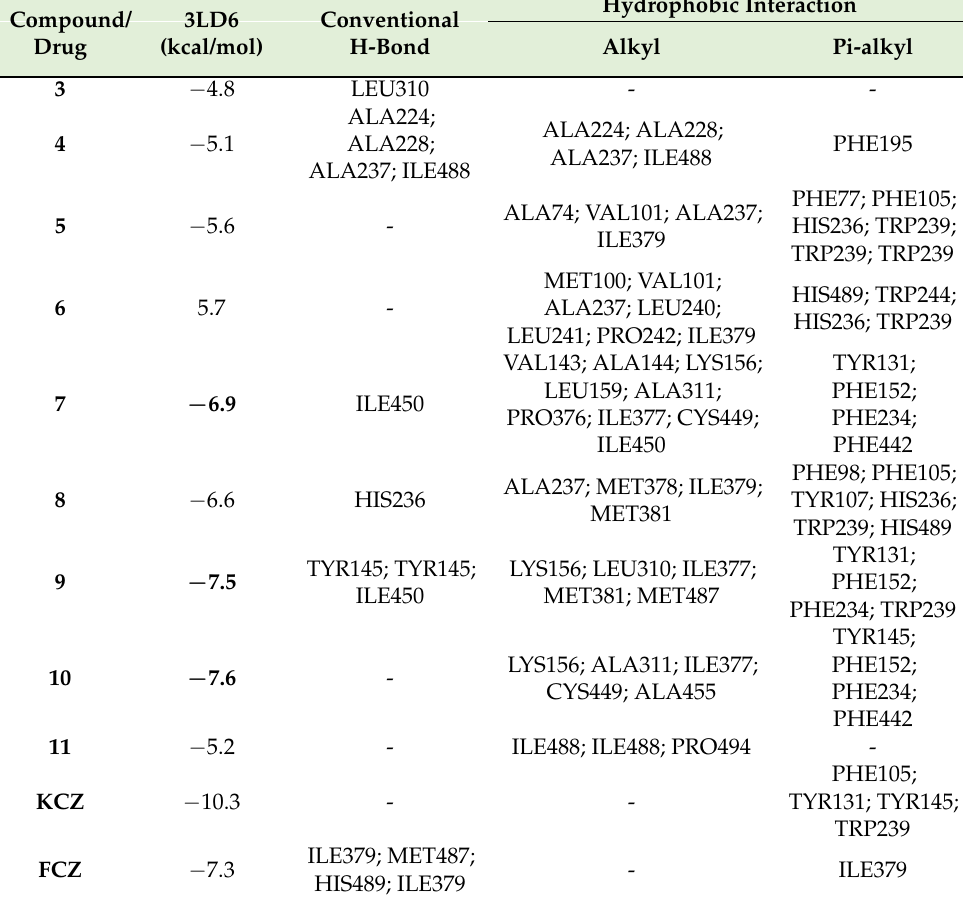
Table 6. Molecular docking of rhamnose esters with lanosterol 14 α -demethylase (CYP51, 3LD6).